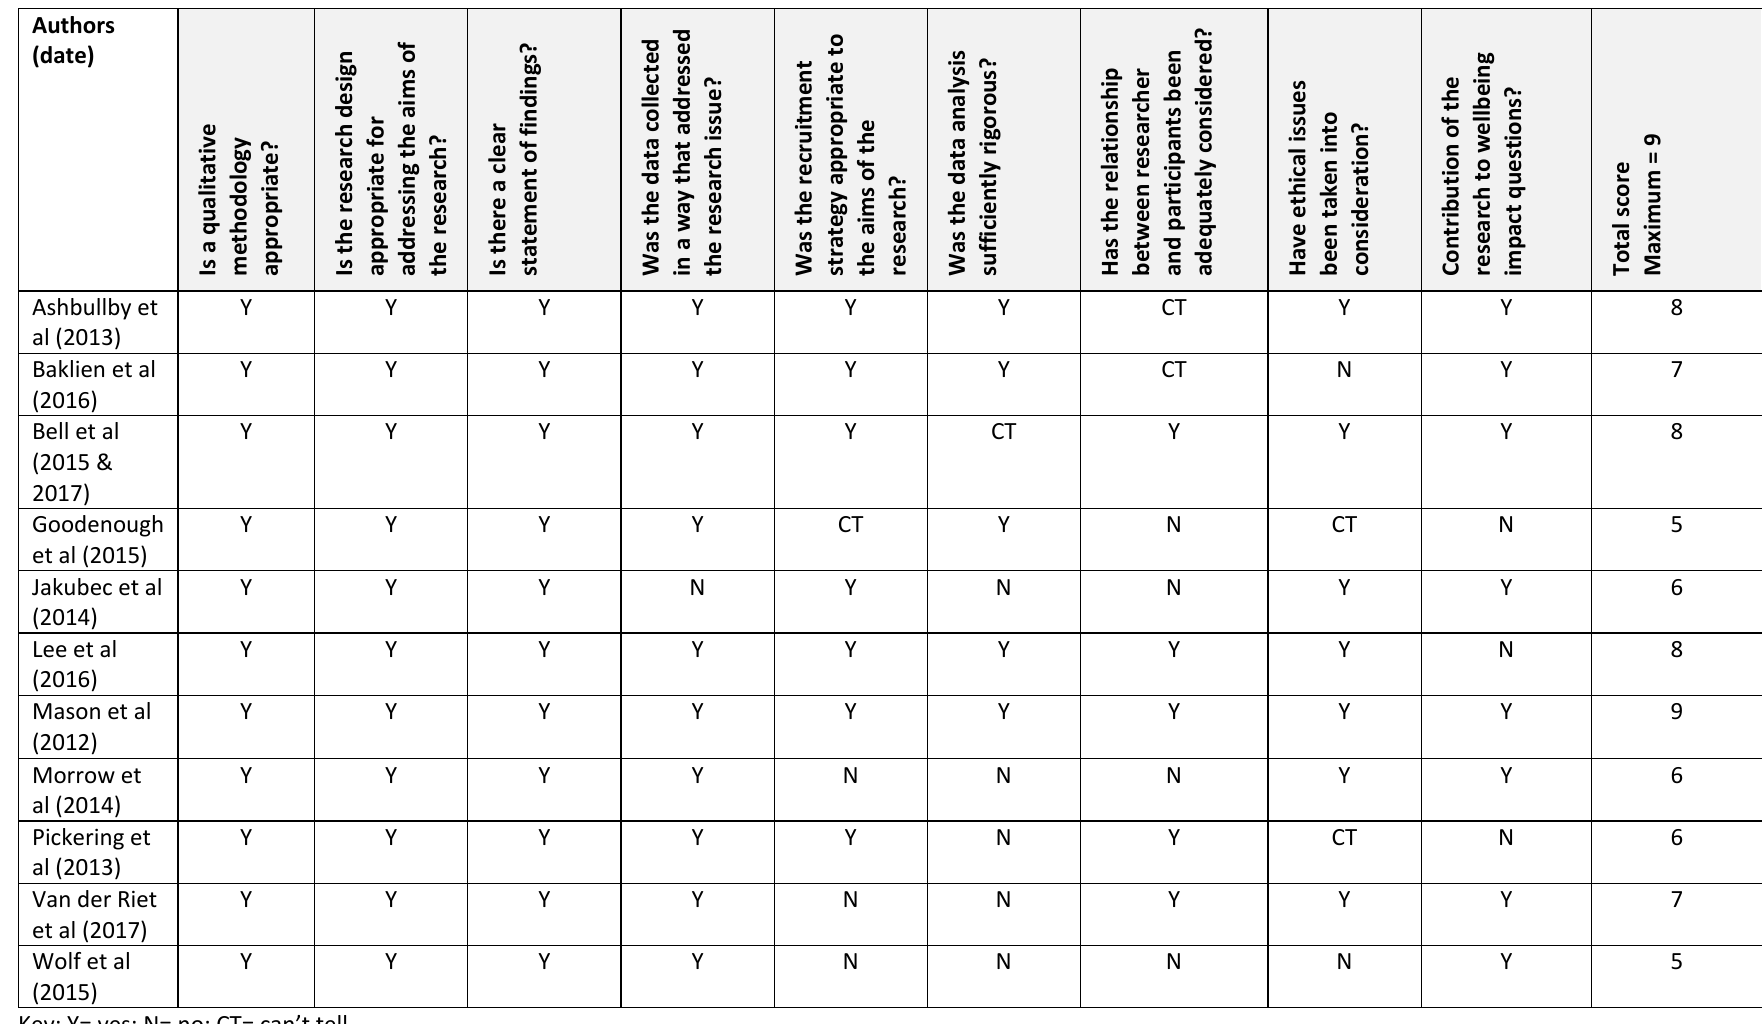
Table 3 Quality checklist scores for qualitative studies